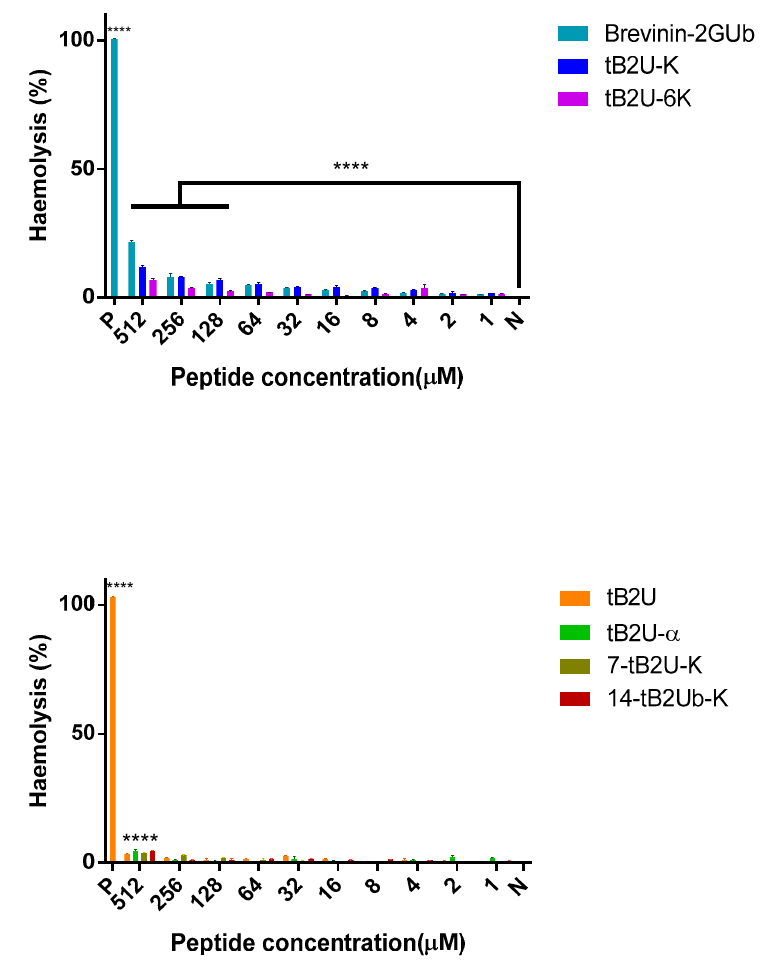
Figure 4. The haemolytic activities of Brevinin-2GUb and its analogues. N represents the negative control and P represents the positive control, which is PBS and 0.1% Triton X-100 in this experiment, respectively. The results were analysed by two-way ANOVA and Dunnett’s multiple comparisons test that compared haemolysis of various concentrations of peptides with negative control. The significance (Table S1) is indicated by ****, which means p < 0.0001. The error bar represents the standard error of the mean (SEM) of the nine replicates from three independent tests.